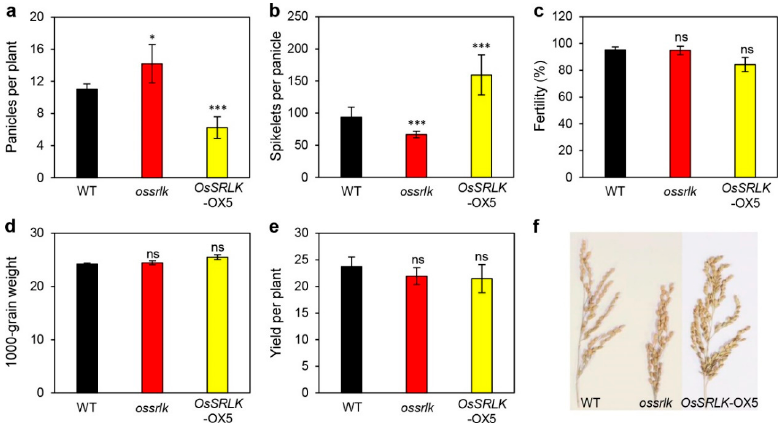
Figure 5. OsSRLK a ff ects the panicle count per plant and spikelets per panicle. Agronomic traits of WT, ossrlk , and OsSRLK -OX5 plants were investigated after harvest in autumn. Comparison of panicles per plant ( a ), spikelets per panicle ( b ), fertility ( c ), 1000-grain weight ( d ), yield per plant ( e ), and phenotype of panicles ( f ) between WT, ossrlk , and OsSRLK -OX5. Mean and standard deviations were obtained from 10 measurements. Asterisks on ossrlk and OsSRLK -OX5 indicate a statistically significant di ff erence from WT, as determined by Student’s t -test (* p < 0.05, *** p < 0.001). ns, not